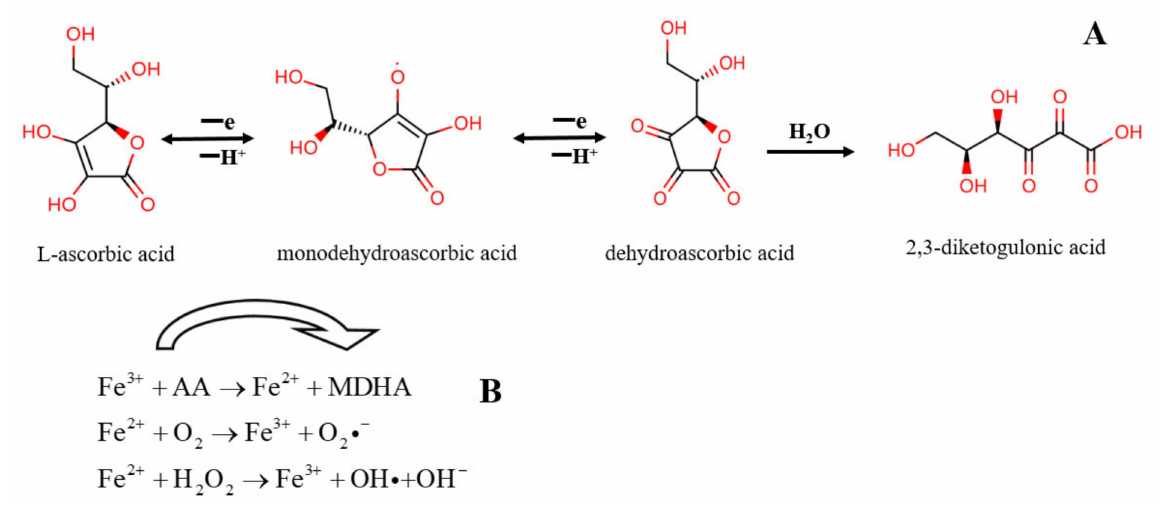
Figure 2. Degradation of L-ascorbic acid to dehydroascorbic acid and 2,3-diketogulonic acid ( A ) and pro-oxidant effects of ascorbic acid ( B